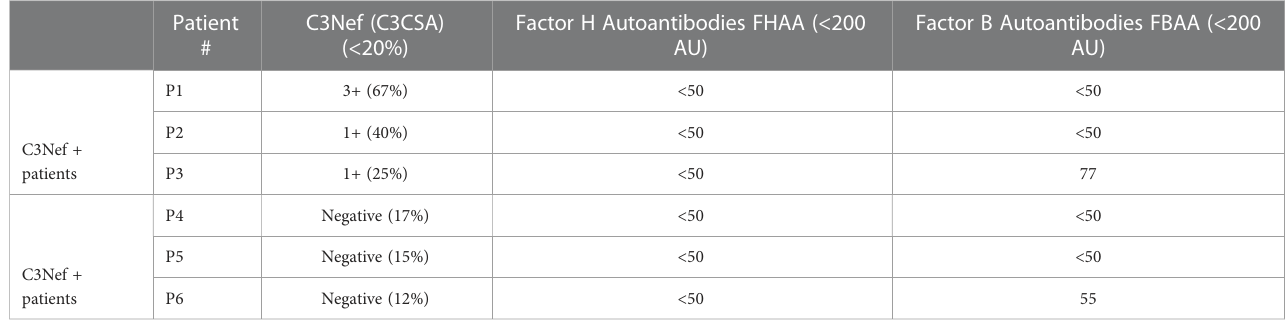
TABLE 1 Patient biomarkers.